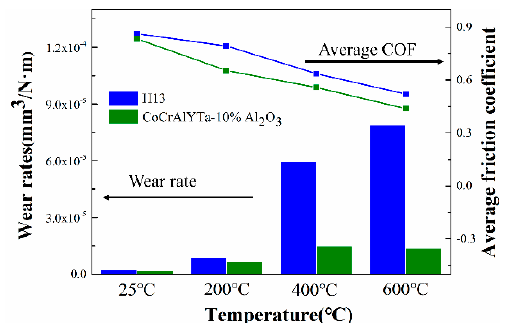
Figure 3. The average COF curves and wear rates of the two kinds of materials at different temperatures.